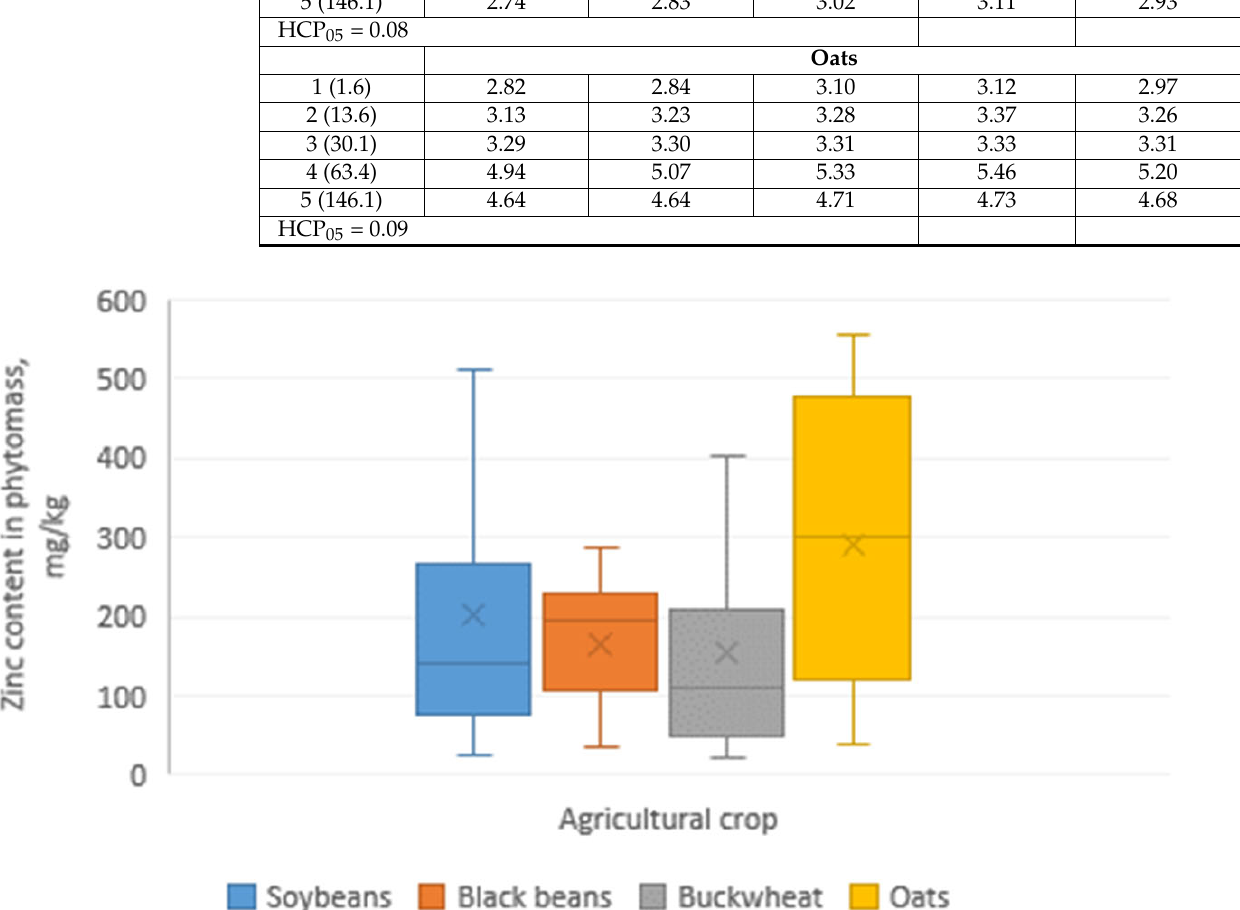
Figure 1. Diagram of copper content in the phytomass of test crops on the variants of the vegetation experiment, depending on the values of the total index of soil contamination.